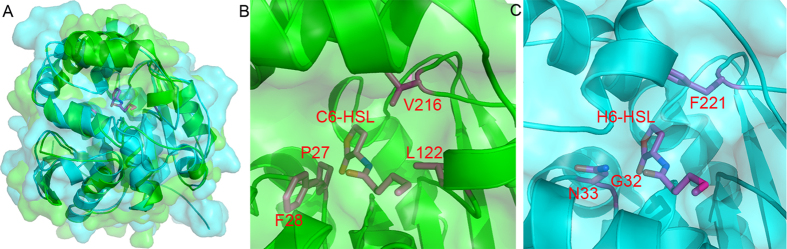
The structure-based rational design to accelerate the reaction rate of Est816.(A) Apo-Est816-M2 (green) is superposed onto that of AidH-C6-HSL complex (PDB code 4G8B, cyan). The C6-HSL ligand is shown in the ball-and-stick model. (B) The close-up view of the substrate-binding pocket of the hypothetical C6-HSL-Est816 complex, with residues tested in the rational design being shown in the ball-and-stick model. (C) The close-up view of the substrate-binding pocket of the AidH-C6-HSL complex.